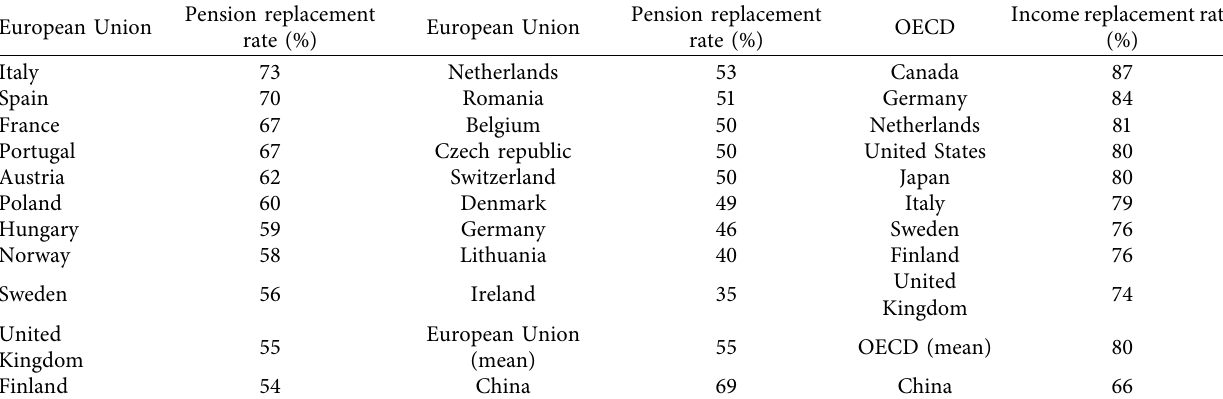
Table 3: Pension security levels in some countries (China and EU in 2018 and OECD in